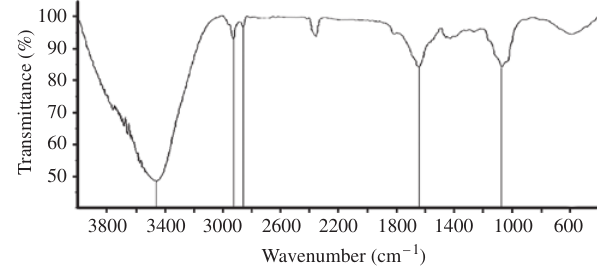
Figure 4: X-ray powder diffractometry (XRD) pattern of the green synthesized iron nanoparticles (INPs); no characteristic peak was observed which indicates the amorphous structure of